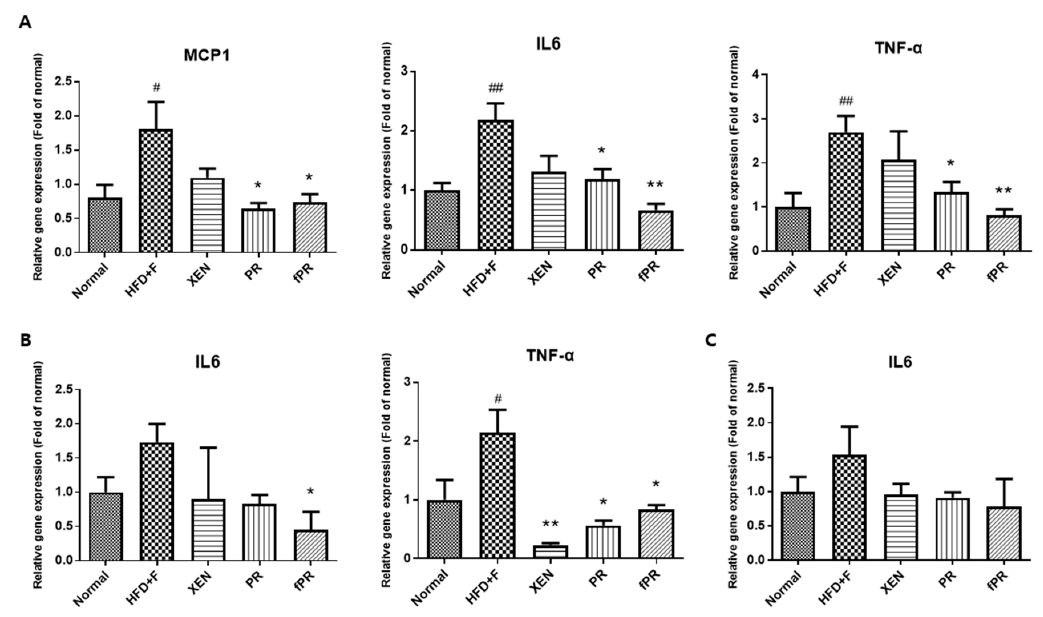
Figure 3. Expression of chemokine (MCP1) and pro-inflammatory cytokine (IL6 and TNF α ) genes in ( A ) intestinal tissue, ( B ) intestinal fat tissue, and ( C ) liver tissue. Data are expressed as means ± SD, and differences were evaluated using one-way ANOVA. # p < 0.05, ## p < 0.01 compared to the normal group; * p < 0.05, ** p < 0.01 compared to the HFD+F-fed group.